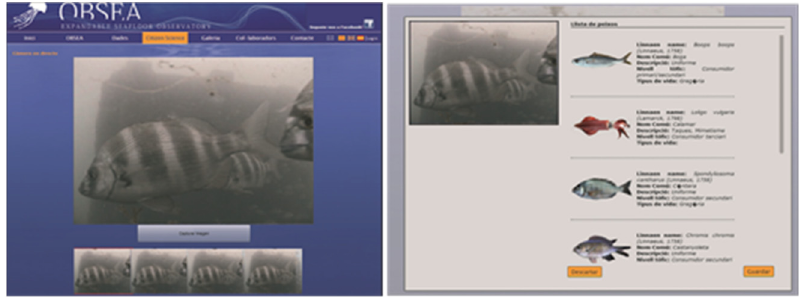
Figure 5. Website for the identification of marine species with OBSEA.